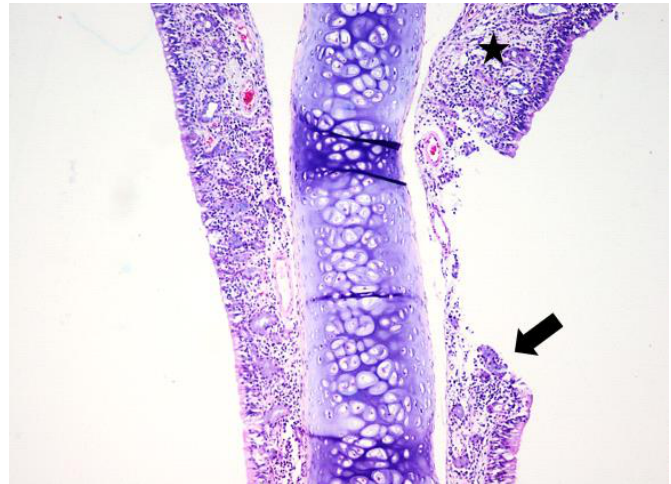
Figure 3. Light micrographs of the rat’s nasal septum, astaxanthin group, at 5 days after the intranasal intervention. The nasal mucosa is disrupted with few cell debris admixed with mucus adherent on the edges of the defect (arrow). The lamina propria of the margins is expanded by mononuclear cells admixed with neutrophils and mild edema (arrow); H&E, ob ×10.